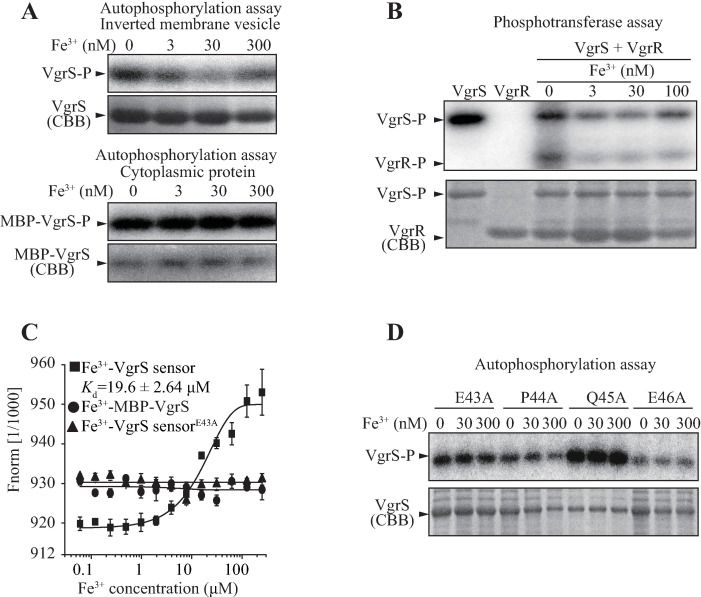
VgrS senses Fe3+ depletion by its sensor region.(A) Fe3+ inhibits the autophosphorylation of full-length VgrS. Upper panels: Inverted membrane vesicles containing full-length VgrS were phosphorylated with 100 μM ATP containing 10 μCi [γ-32P]ATP. Fe3+ was added at different concentrations. Lower panels: Soluble, truncated VgrS is not stimulated by Fe3+. MBP-VgrS without the input and transmembrane domains was used in the autophosphorylation assay. The experiment was repeated three times. (B) Iron excess decreased the phosphotransfer level from VgrS to VgrR. Full-length VgrS membrane was phosphorylated as described in (A) for 2 min in the presence of Fe3+, 15.0 μM VgrR was added into the mixture for 20 sec before stopping the reaction. (C) VgrS sensor directly binds Fe3+. 2 μM VgrS sensor, truncated VgrS (MBP-VgrS) and VgrSE43A sensor were used in a microscale thermophoresis (MST) assay. The titer of Fe3+ ranged from 0.061 to 250 μM. The experiment was repeated three times. (D) Substitution of residues in the ExxE motif of VgrS sensor eliminated VgrS’s sensing of Fe3+. Inverted membrane vesicles with full-length VgrSE43A, VgrSP44A, VgrSQ45A and VgrSE46A were used in the autokinase assay as in (A). Fe3+ was added into the reaction mixtures. The experiment was repeated twice. In (A, B, and D), the reaction was stopped by adding loading buffer before SDS-PAGE separation and autoradiography. The gel was stained by Coomassie brilliant blue (CBB) to check the amount of proteins.